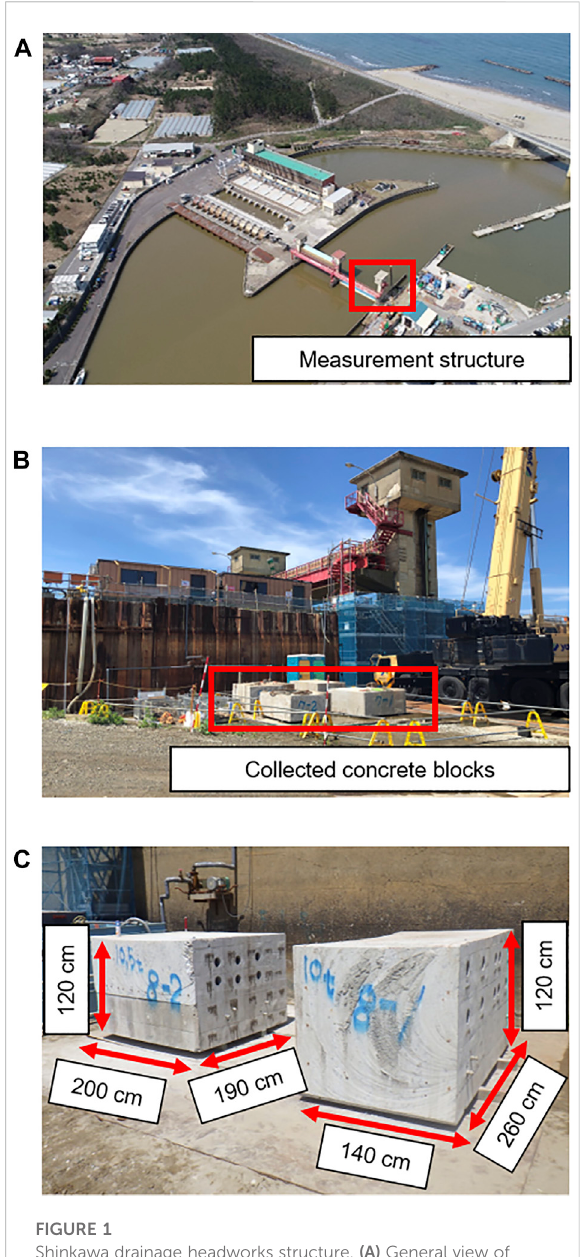
FIGURE 1 Shinkawa drainage headworks structure. (A) General view of the facility. (B) Overview of collected concrete blocks. (C) Sampling site (concrete